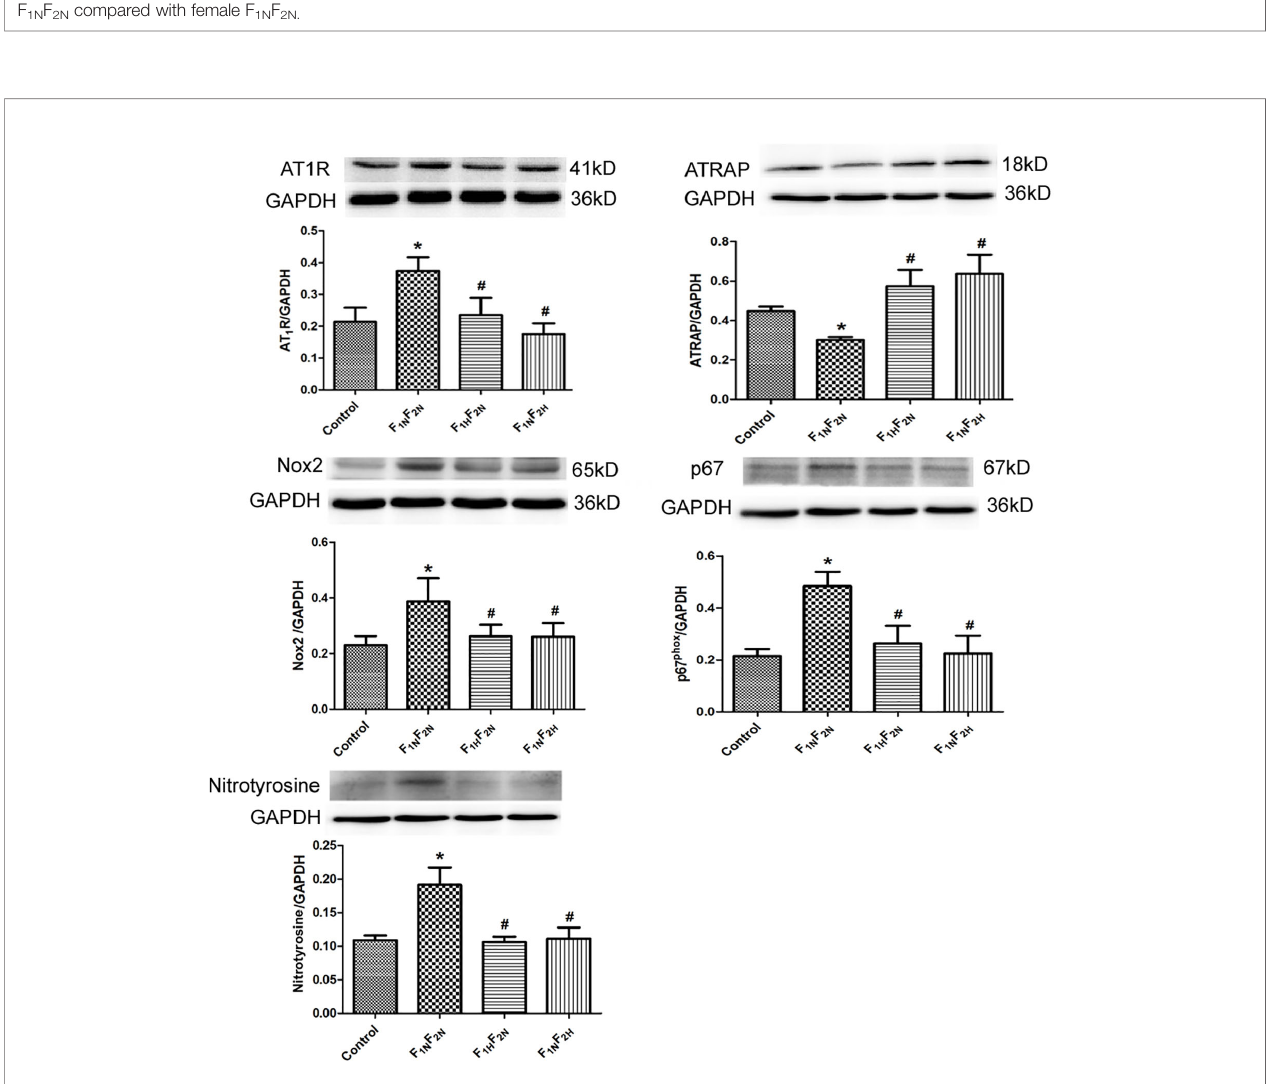
FIGURE 5 | Western blot analysis of protein expression of AT1R, ATRAP, Nox2, p67phox, and nitrotyrosine in nucleus tractus solitarii (NTS) in male offspring from the control, F 1N F 2N (offspring of RVH rats), F 1H F 2N (RVH rats treated with NaHS, offspring without NaHS), and F 1N F 2H (maternal RVH rats treated without NaHS and offspring with NaHS after weaning) groups. Data are mean ± SE ( n = 12). * P < 0.05 compared with control and # P < 0.05 compared with F 1N F 2N . GAPDH was used to